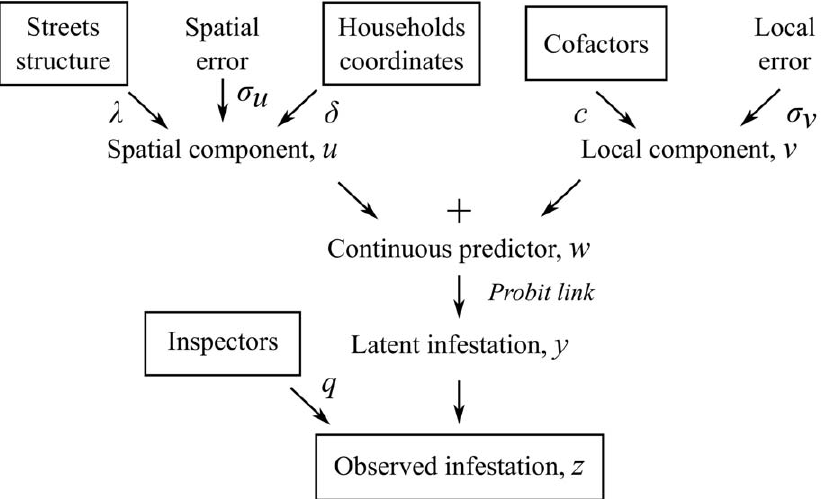
Figure 1. General structure of the Gaussian Field Latent Class model. Working backward, we consider the infestation data z to be the result of a latent infestation status y , observed by imperfect inspectors of sensitivity q . The true infestation y is a binary manifestation of an underlying continuous infestation predictor w . Cofactors and a local error term, E , form the local component. The spatial component u is modeled as a Gaussian field. The fit parameters, d and l , respectively tune how distances between neighbors and the streets define the spatial dependency between households in the spatial component.